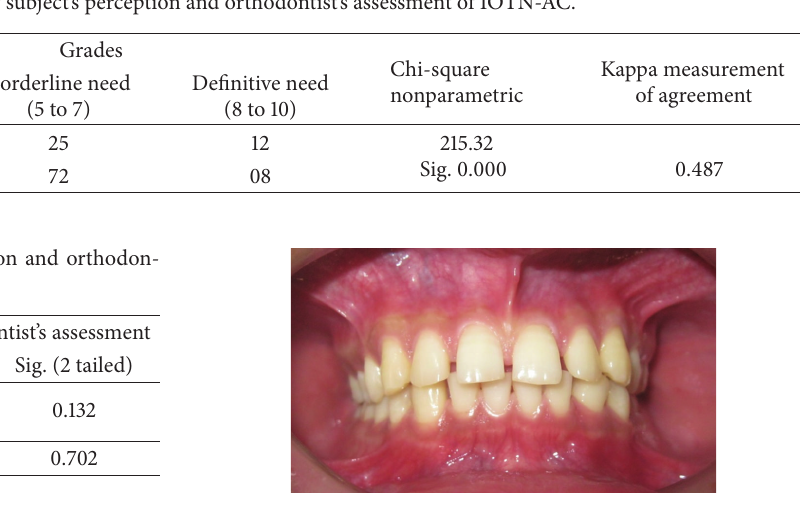
Figure 3: IOTN-AC Grade 5–7: borderline/moderate need for orthodontic treatment.